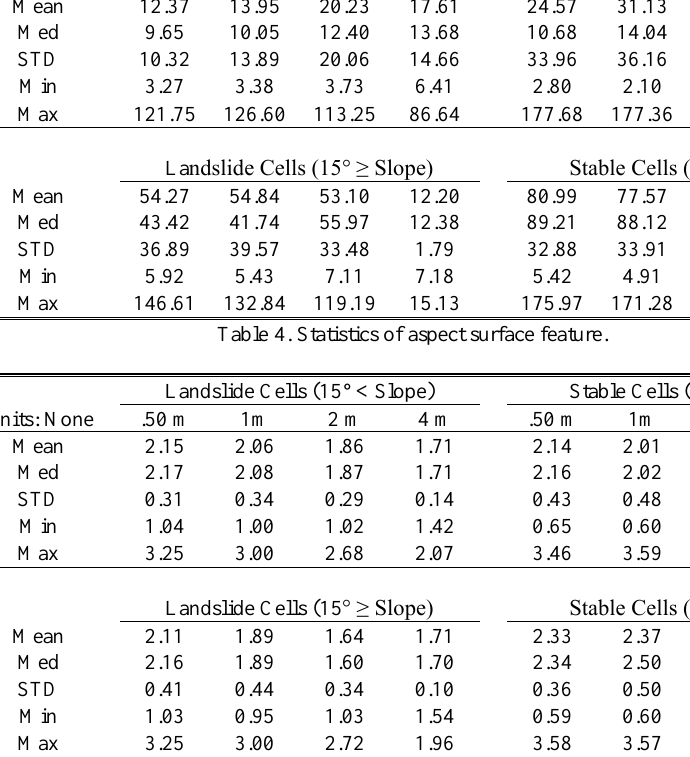
Table 5. Statistics of ln(λ 1 /λ 3 ) eigenvalue ratios surface